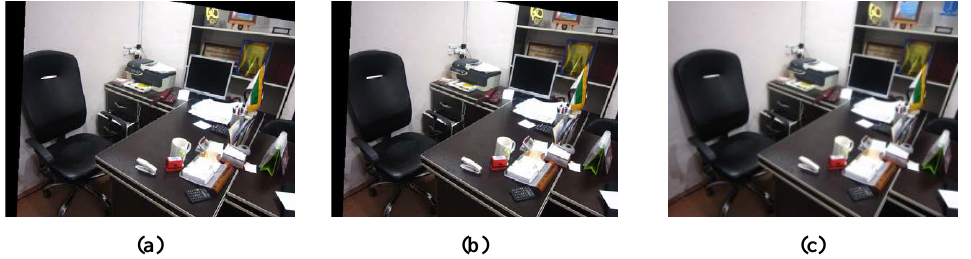
Figure 14. Virtual view synthesis by different methods for "office 1" (a) the virtual view used in [16] considering n=5 , (b) the virtual view by the proposed method considering n=5 ,